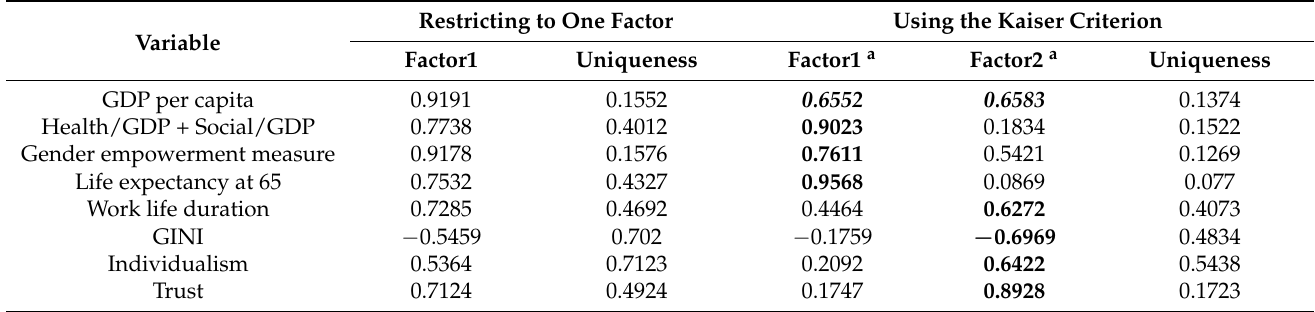
Table A4. Results of factor analyses of welfare state variables.